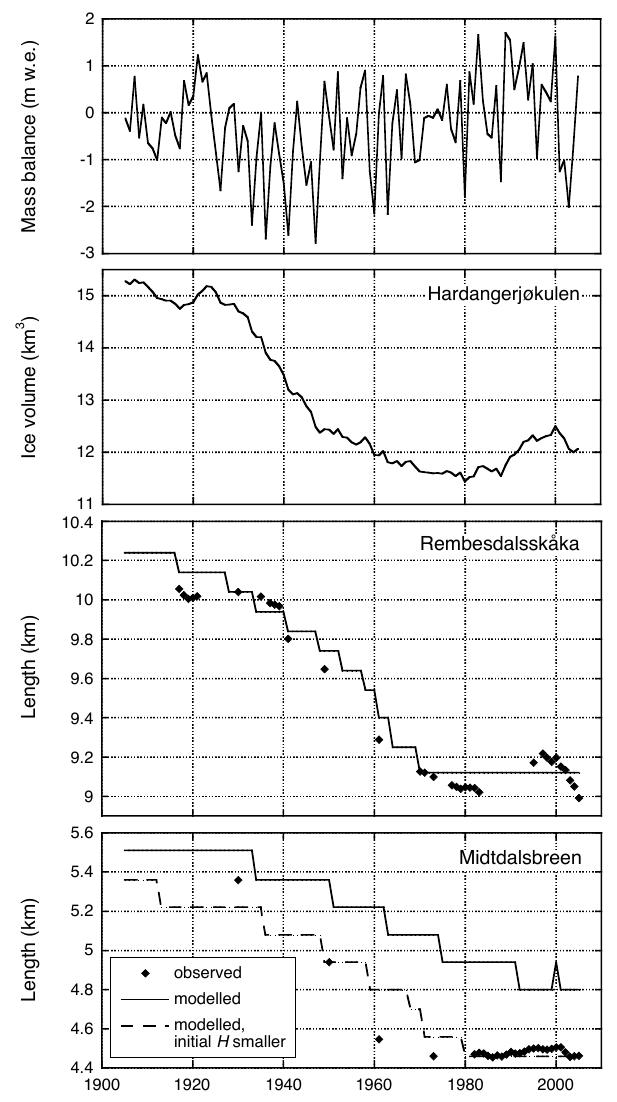
Fig. 10. Modelled net mass balance and ice volume for the entire ice cap and observed and simulated frontal variations at Rembes- dalsskåka and Midtdalsbreen for the period 1905–2005. For Midt- dalsbreen, an additional simulation starting from a smaller initial ice thickness is